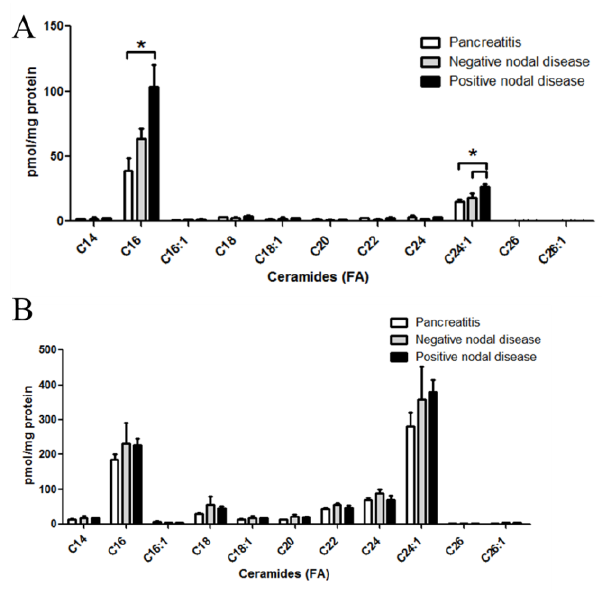
Figure 1. Altered ceramide levels in patient specimens with pancreatic cancer. LC-MS/MS was utilized to quantify ceramides from patient specimens. Ceramides with a d18:1 backbone with fatty acids from 14 to 26 carbons were assessed. Molecular species of ceramides were quantified from pancreas tissues ( A ); and corresponding plasma samples ( B ) from patients with pancreatitis, non-metastatic (nodal negative) pancreatic cancer, or metastatic (nodal positive) pancreatic cancer. * = p < 0.05 assessed by t -test analysis.